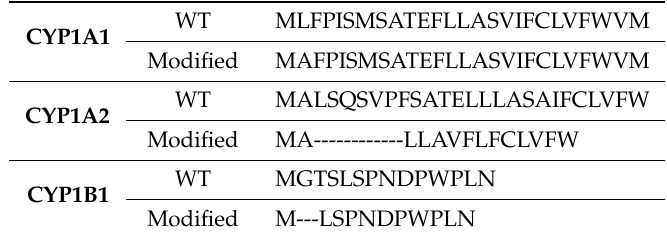
Table 2. N-terminal modifications of CYPs used in this